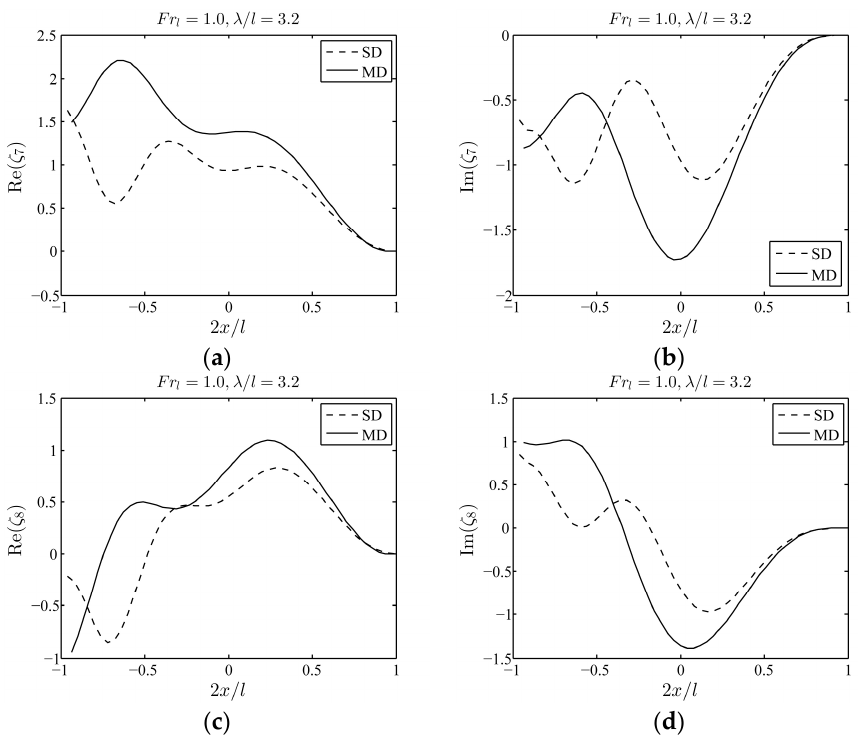
Figure 6. The comparison of profiles of radiation waves ζ 7 , ζ 8 on the interface due to fluctuating air pressure at y = 0. The Froude number of the air cushion in the PACSCAT is F rl = 1.0, and the wave length to air cushion length ratio is λ / l = 3.2. ( a ) Real part of ζ 7 ; ( b ) Imaginary part of ζ 7 ; ( c ) Real part of ζ 8 ; ( d ) Imaginary part of ζ 8